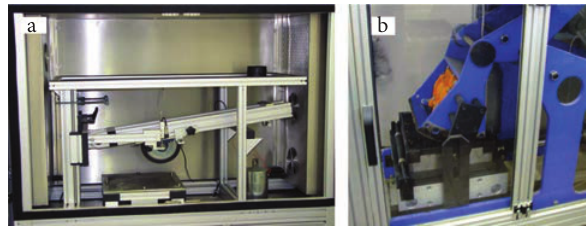
Fig. 3. Test setup for (a) rutting test and (b) slab compaction